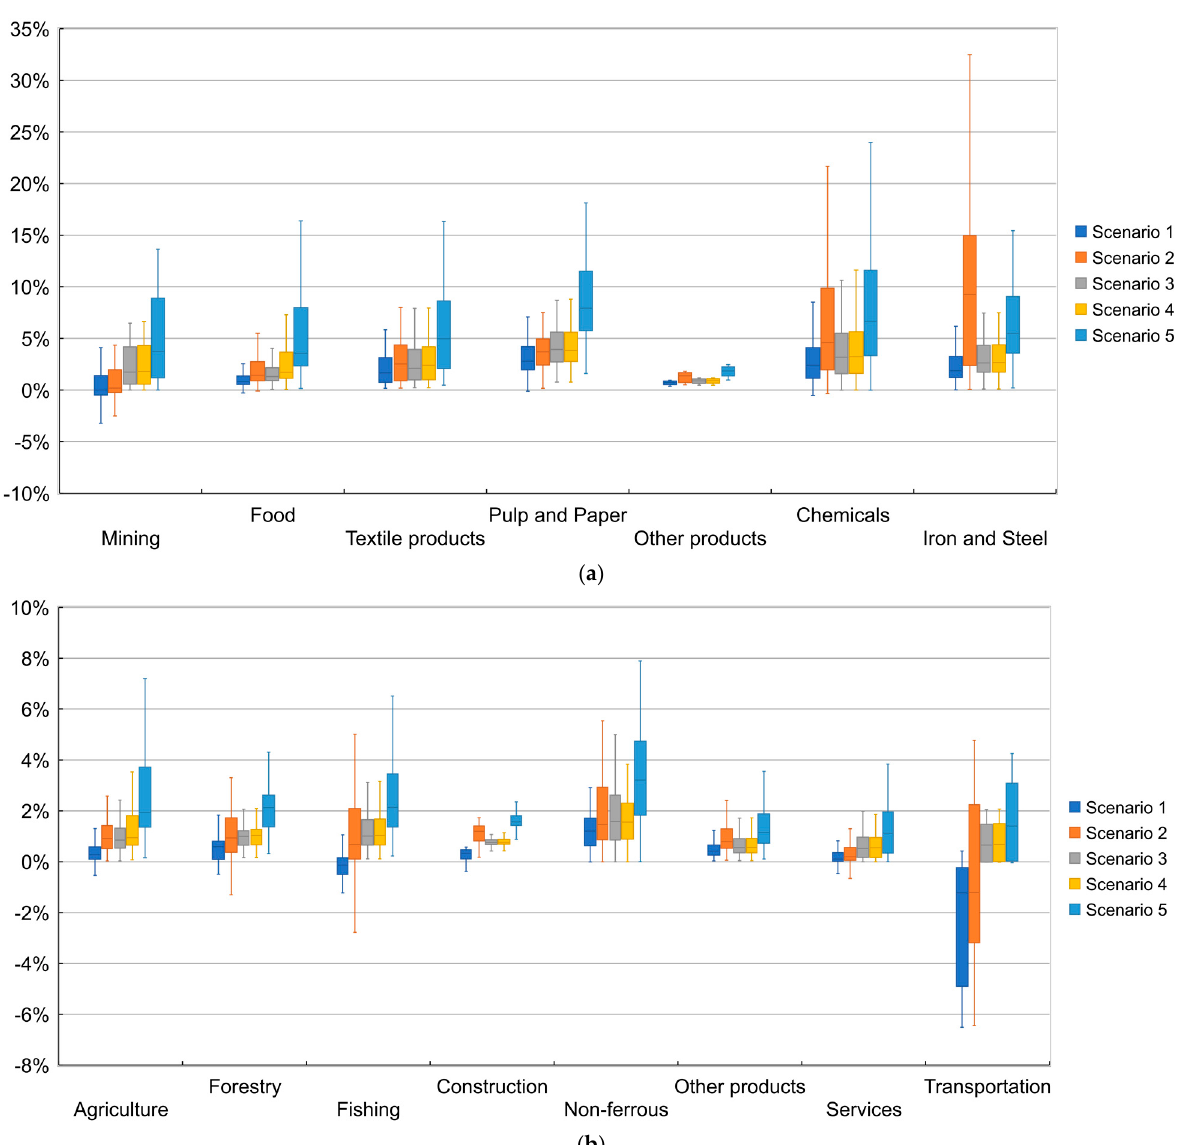
Figure 1. Percentage change in product prices by taxation scenario. The boxes show the inter quartile range (IQR). The horizontal lines in the boxes are the median. The whiskers indicate maximum or 3rd quartile +1.5 IQR and minimum or 1st quartile − 1.5 IQR. ( a ) Sectors with relatively large price changes, ( b ) other